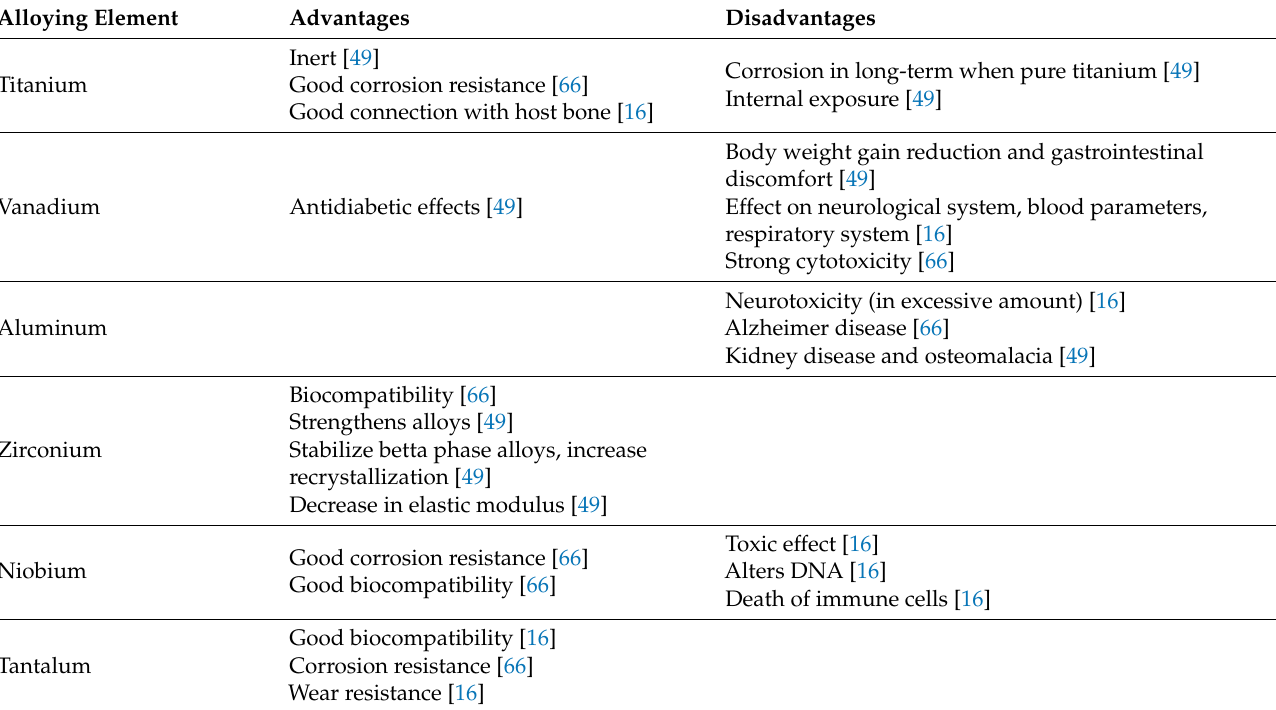
Table 3. Advantages and disadvantages of different alloying